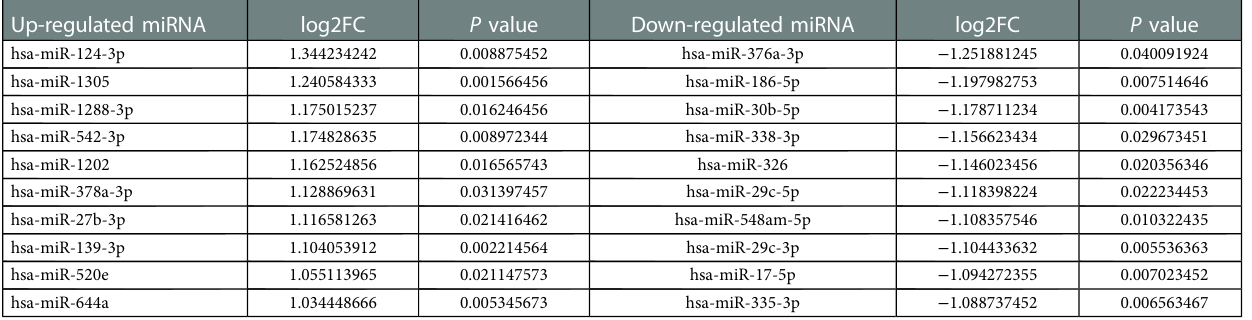
TABLE 4 Top 10 DmiREs from GSE105449.